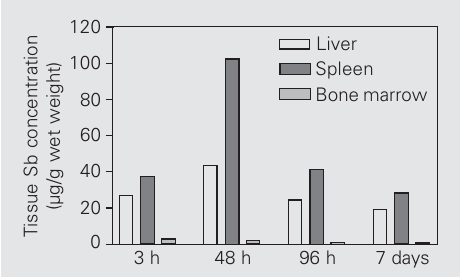
Figure 1. Distribution of anti- mony (Sb) concentrations deter- mined in the liver, spleen and bone marrow of dogs at differ- ent times after a single intrave- nous bolus injection of lipo- some-encapsulated meglumine antimoniate at 3.8 mg Sb/kg body